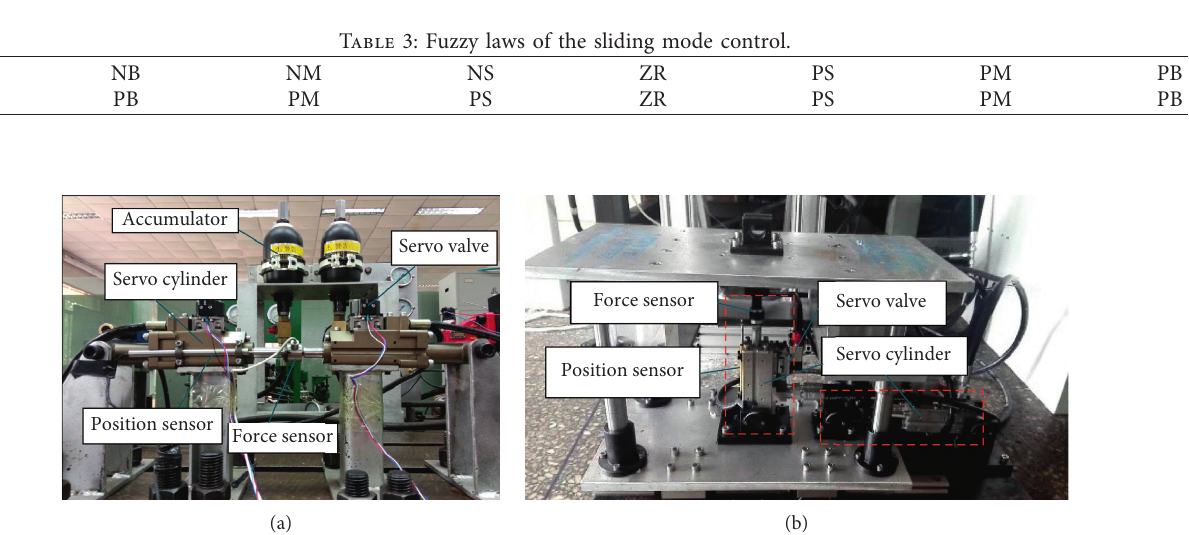
Figure 7: (a) HDU performance test platform. (b) Load simulation test